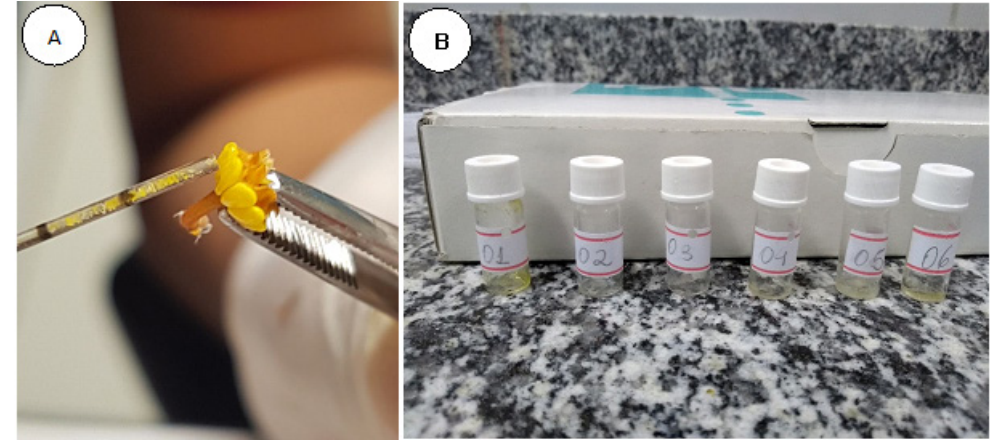
Fig 1 . Collecting oil from nance ( Byrsonima sericea ) flowers. A) using a capillary tube (10 μ L) for removing the sample directly from the epithelial gland. B) floral oil kept in a 4 ml